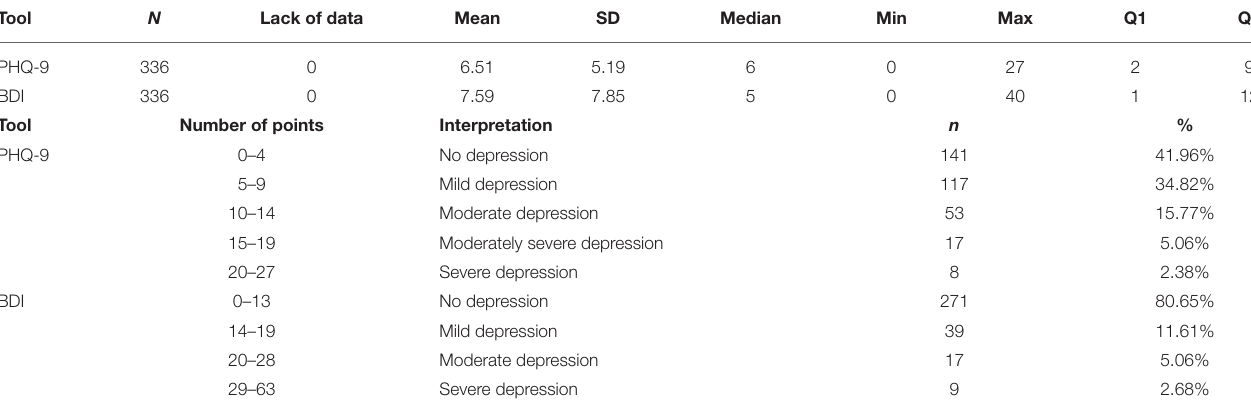
TABLE 2 | Scores and standards for the PHQ-9 and BDI questionnaires. Tool